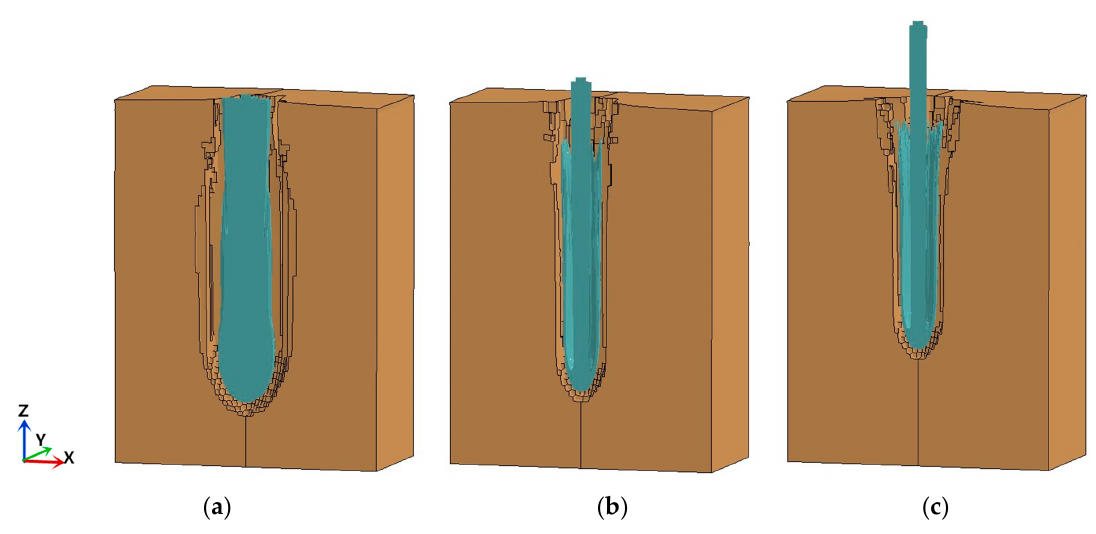
Figure 11. Flow situations under different standoff distances. ( a ) L = 1 mm; ( b ) L = 3 mm; ( c ) L = 9